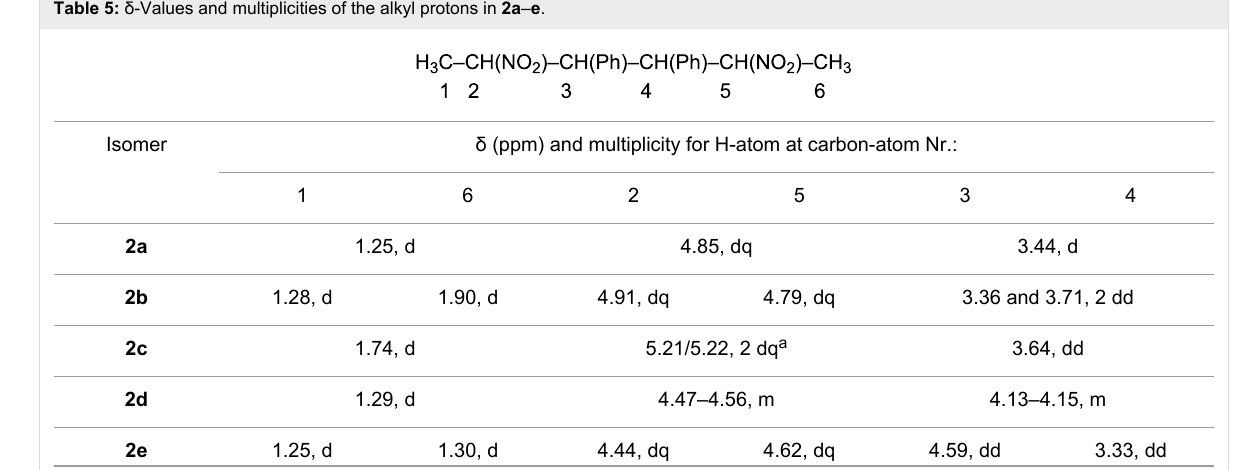
Table 5: δ -Values and multiplicities of the alkyl protons in 2a – e .